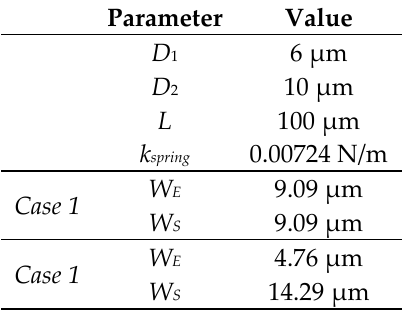
Figure 2. Schematic of the simulated structure. Table 1. Parameters used in the